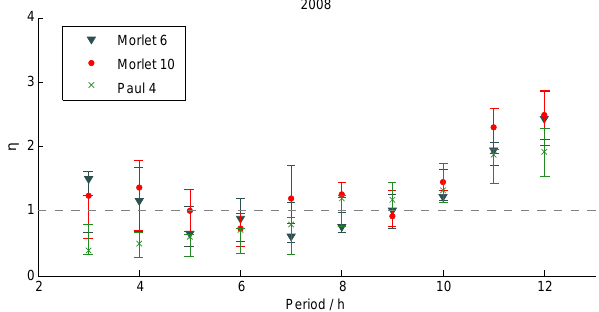
Fig. 8. Same as Fig. 5 for 2008, but with 12h of lidar data removed from the